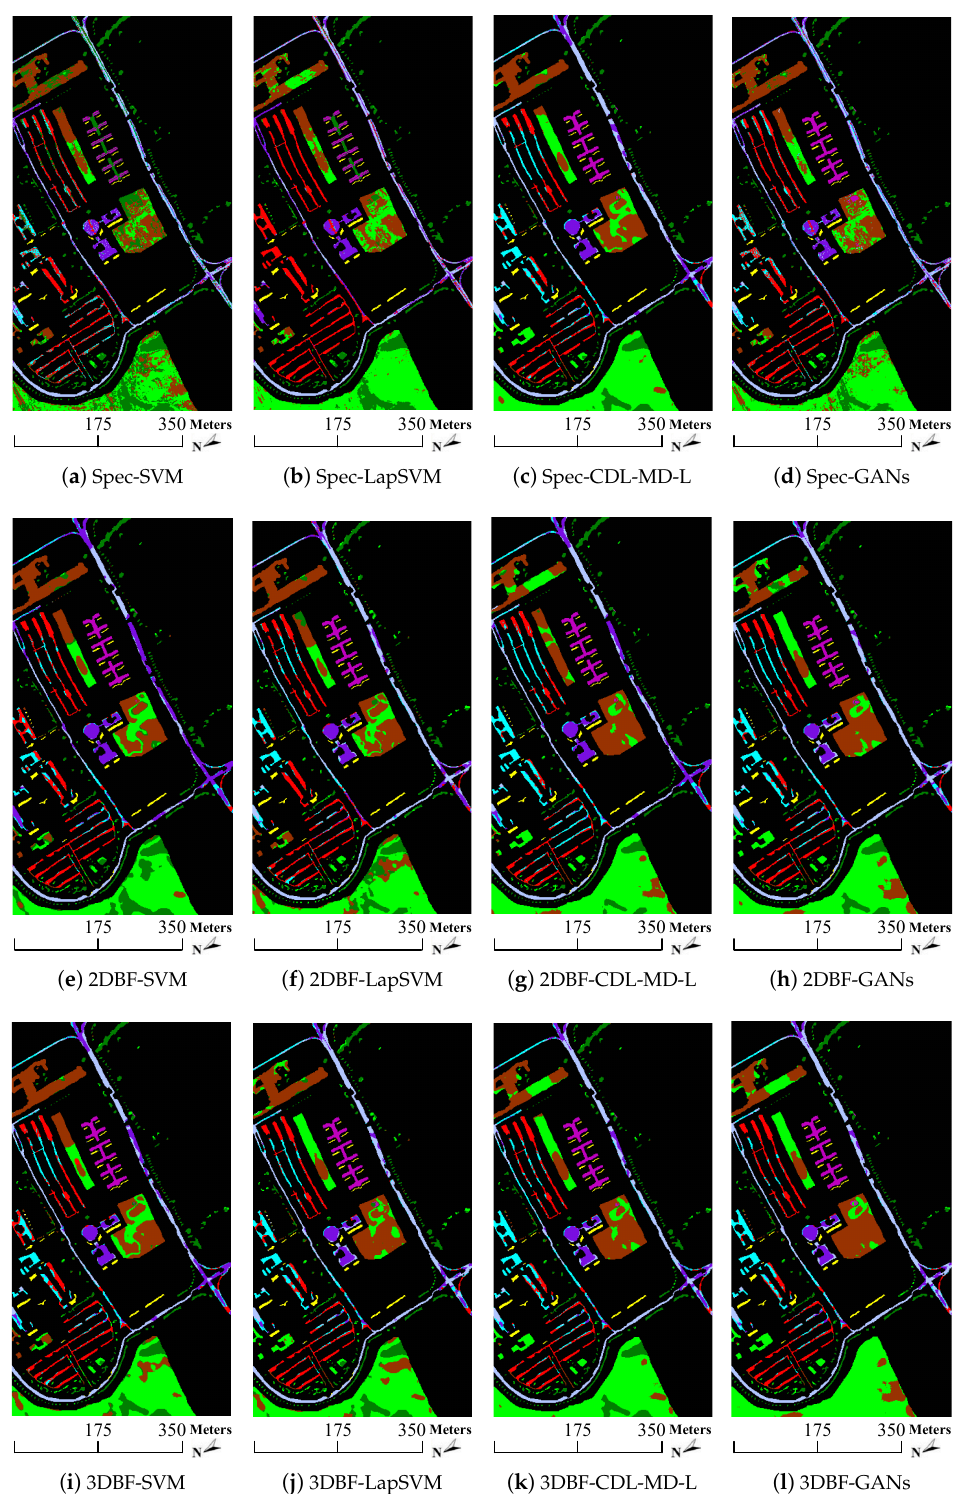
Figure 12. Classification maps of the University of Pavia data with 5 samples per